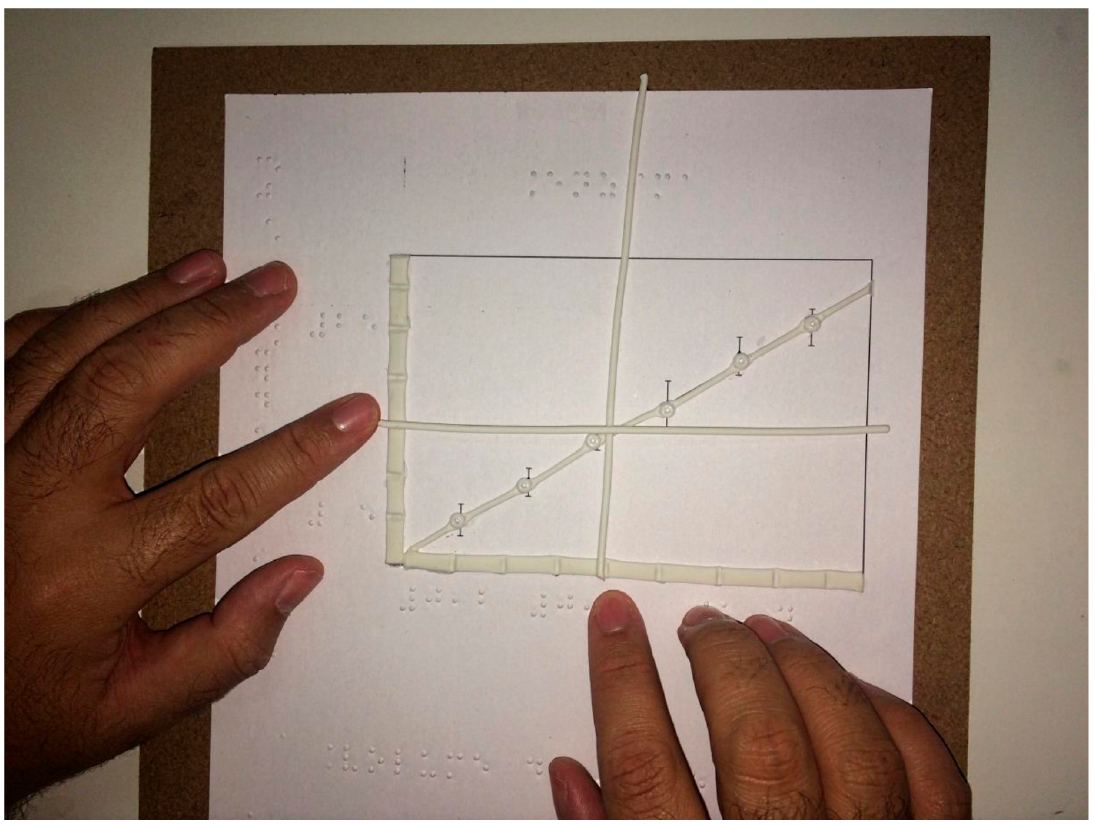
Figure 4. Use of the 3D graph by a blind student. Two guides made of cold porcelain were used by the student to locate the data points in regarding to the axis.